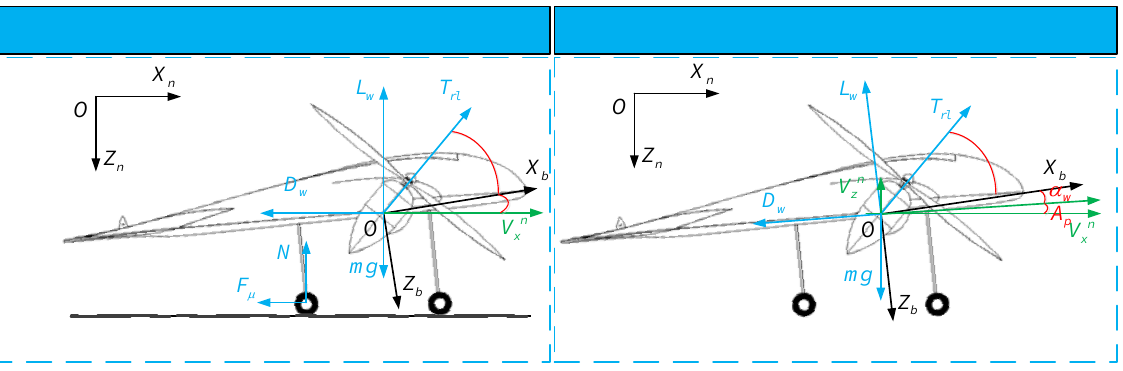
Figure 10. Force analysis in taxiing and takeoff stages of the STO.